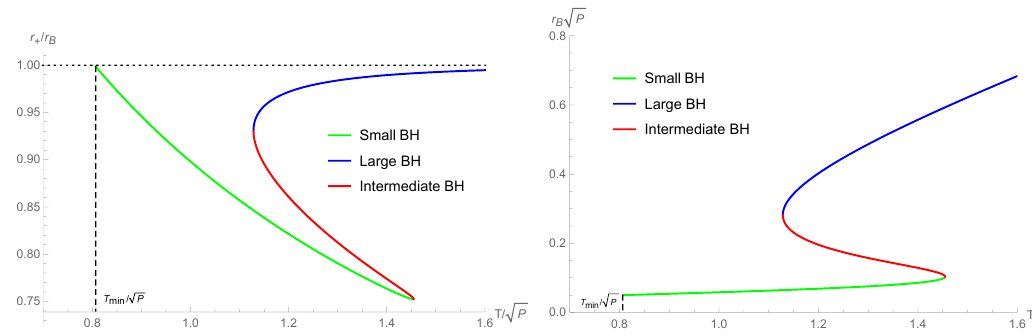
p p P against T= P for a RN black hole in a cavity with